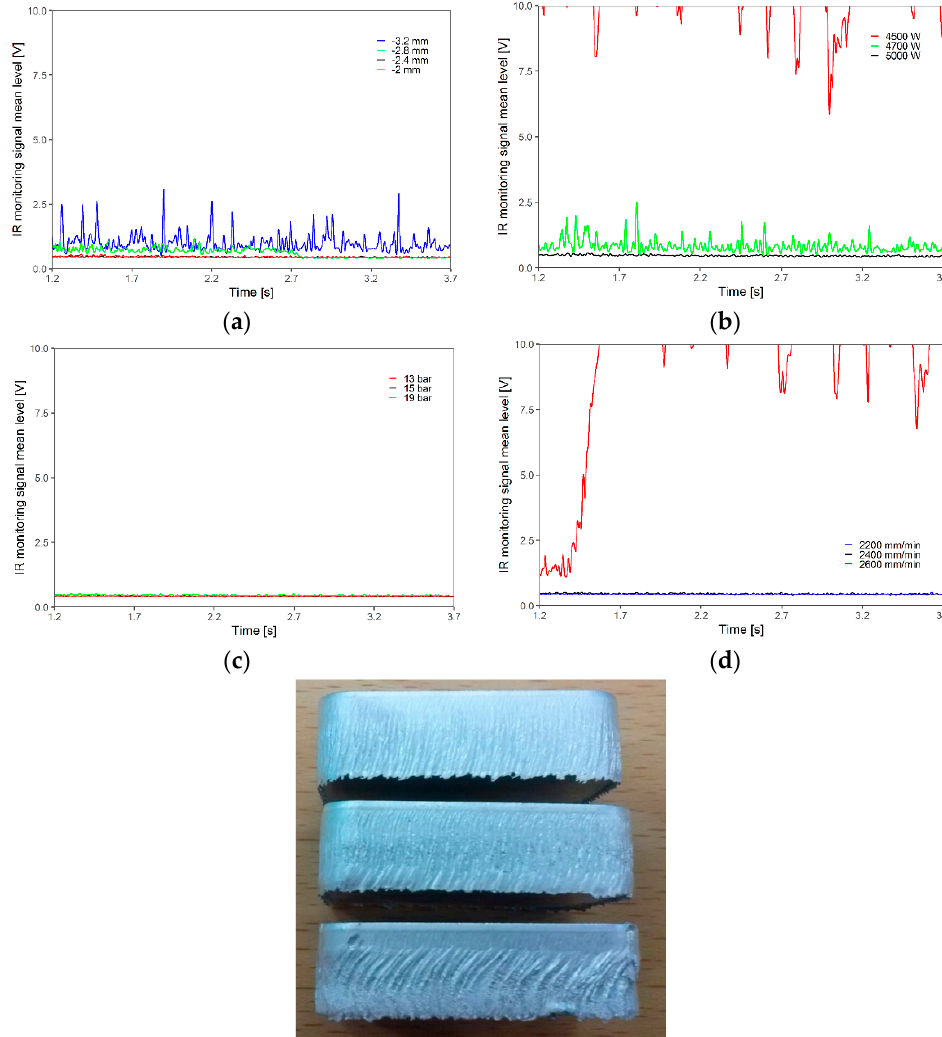
Figure 4. IR monitoring mean levels (gain 2) obtained during the laser cutting of aluminum of 10 mm with nitrogen, comparing the ideal cutting conditions (black line) with variations in: ( a ) focal position; ( b ) laser power; ( c ) gas pressure; and ( d ) velocity. ( e ) Optical images of cut samples with the ideal cutting parameters (top), with a focal position of − 2.8 mm (center) and with a focal position of − 3.2 mm (bottom).